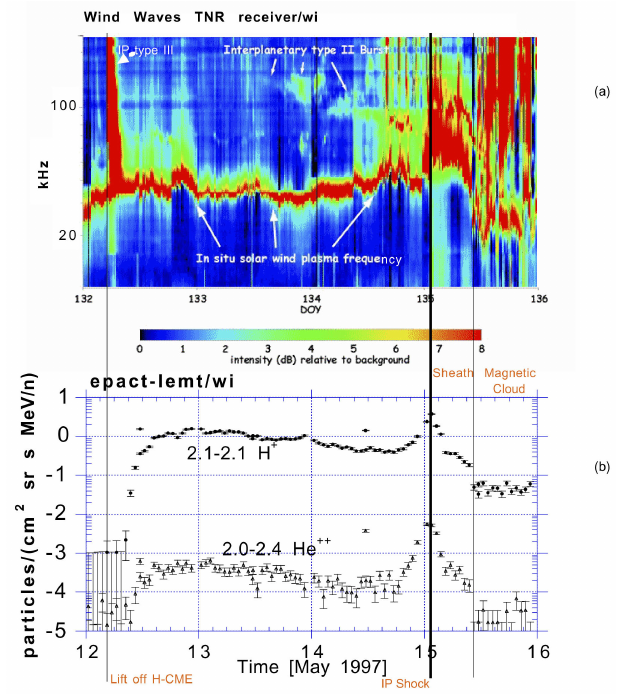
Fig. 1. Top panel shows radio frequency spectrogram (10–400kHz) from start to end of Event 9. The color scale is chosen to highlight weak Type II radio bursts (top arrows on 13 and 14 May 1997). Solid red radio emissions on the left are Type III radio bursts that mark the approximate start of the event at the Sun. The start of the right, low wave enhancements (below plasma line) marks the time of the passage of the shock on 15 May 1997. Bottom panel shows on the left the rise of the energetic particle (EP) fluxes, indicating the start of the EP gradual event. The EP spike marks the shock passage on 15 May 1997 and the second flux dip, on the right, indicates the starting time of the passage of the interplanetary magnetic cloud (IMC) at